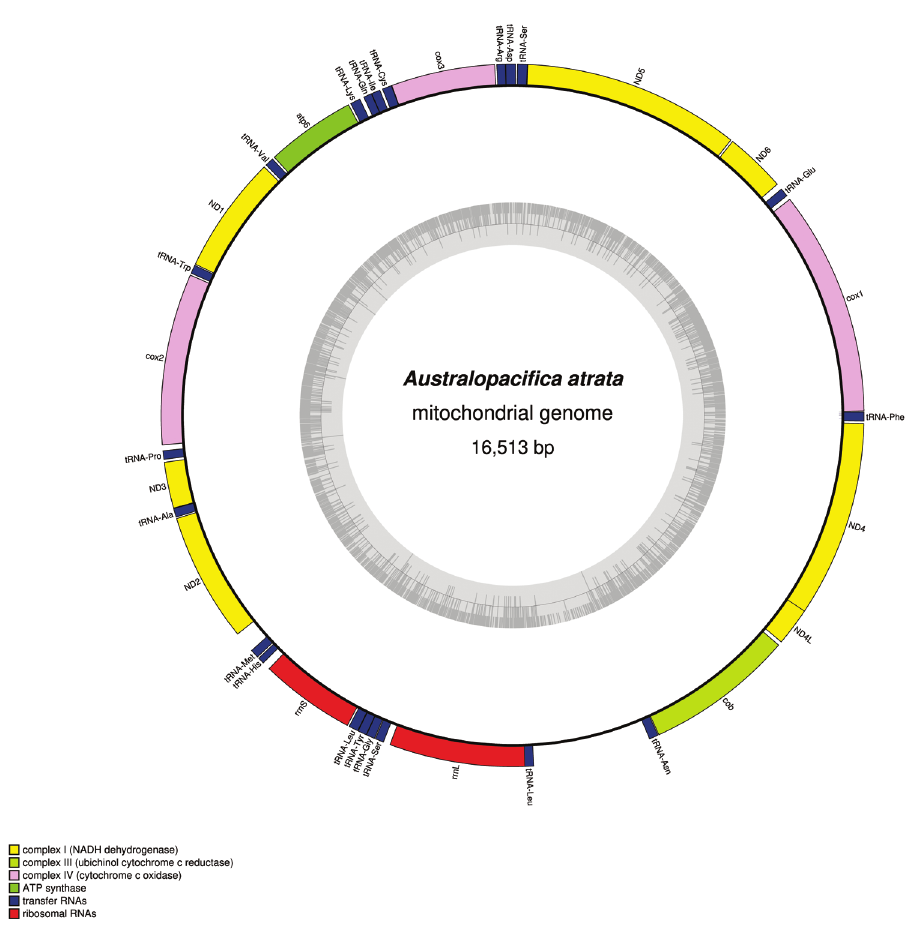
Figure 3. Map of the mitochondrial genome of Australopacifica atrata (Steel,